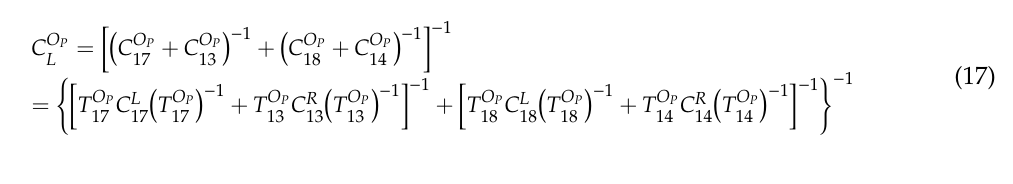
Figure 9. Input compliance model of the HRFB in the y-axis direction. ( a ) Equivalent spring model of the HRFB; ( b ) The simplified model of the HRFB.